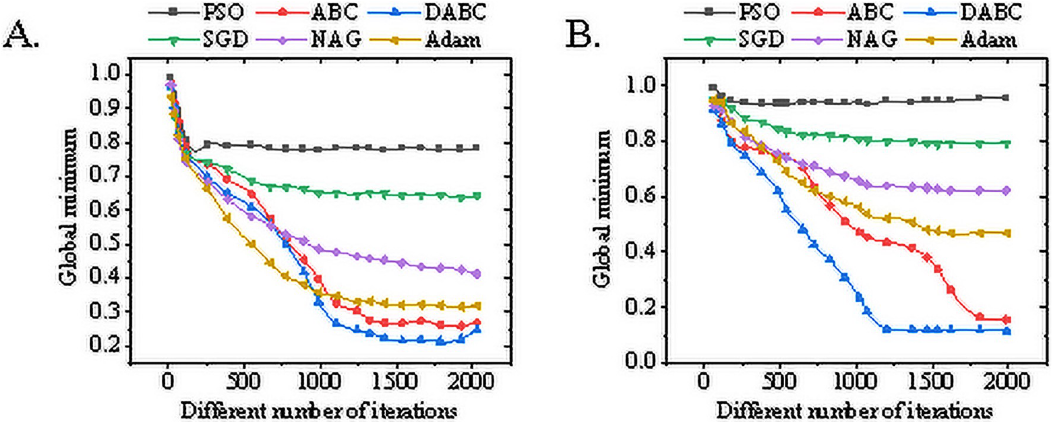
Fig 5. Results of searching performance of different algorithm models on the Sphere function and Griewank function.